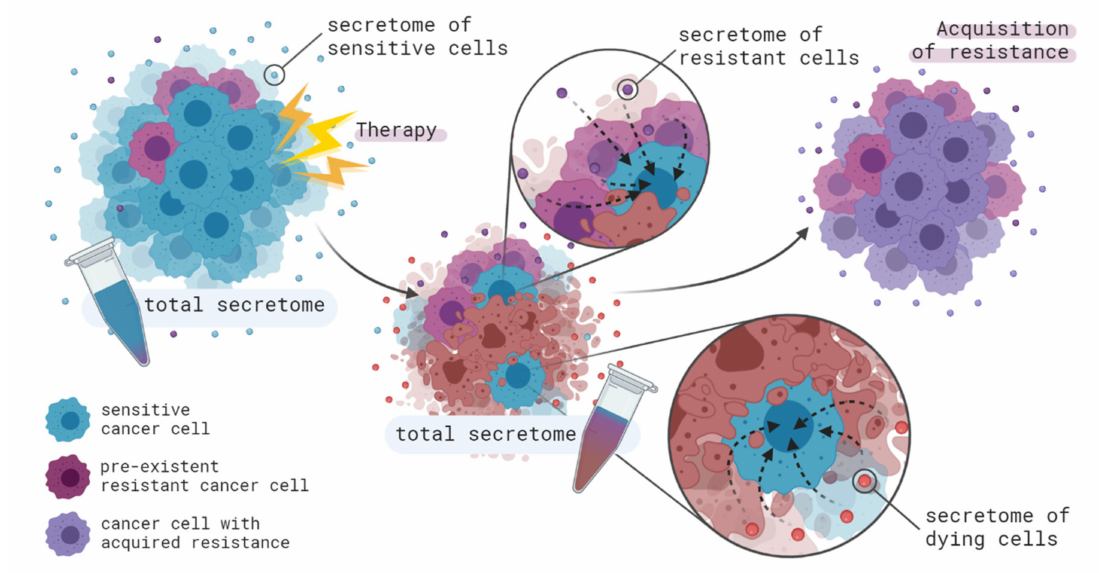
Figure 4. Features of tumor intercellular communication in response to therapy. During therapy, most of the sensitive tumor cells die, which leads to a decrease of their fraction in the tumor population and an increase in the proportion of resistant clones. Similarly, the composition of the total cell secretome and, consequently, its ability to participate in the process of acquiring therapy resistance change. Moreover, tumor cells dying under the e ff ect of therapy release a number of molecules into the extracellular space which can induce the acquisition of resistance in untreated tumor